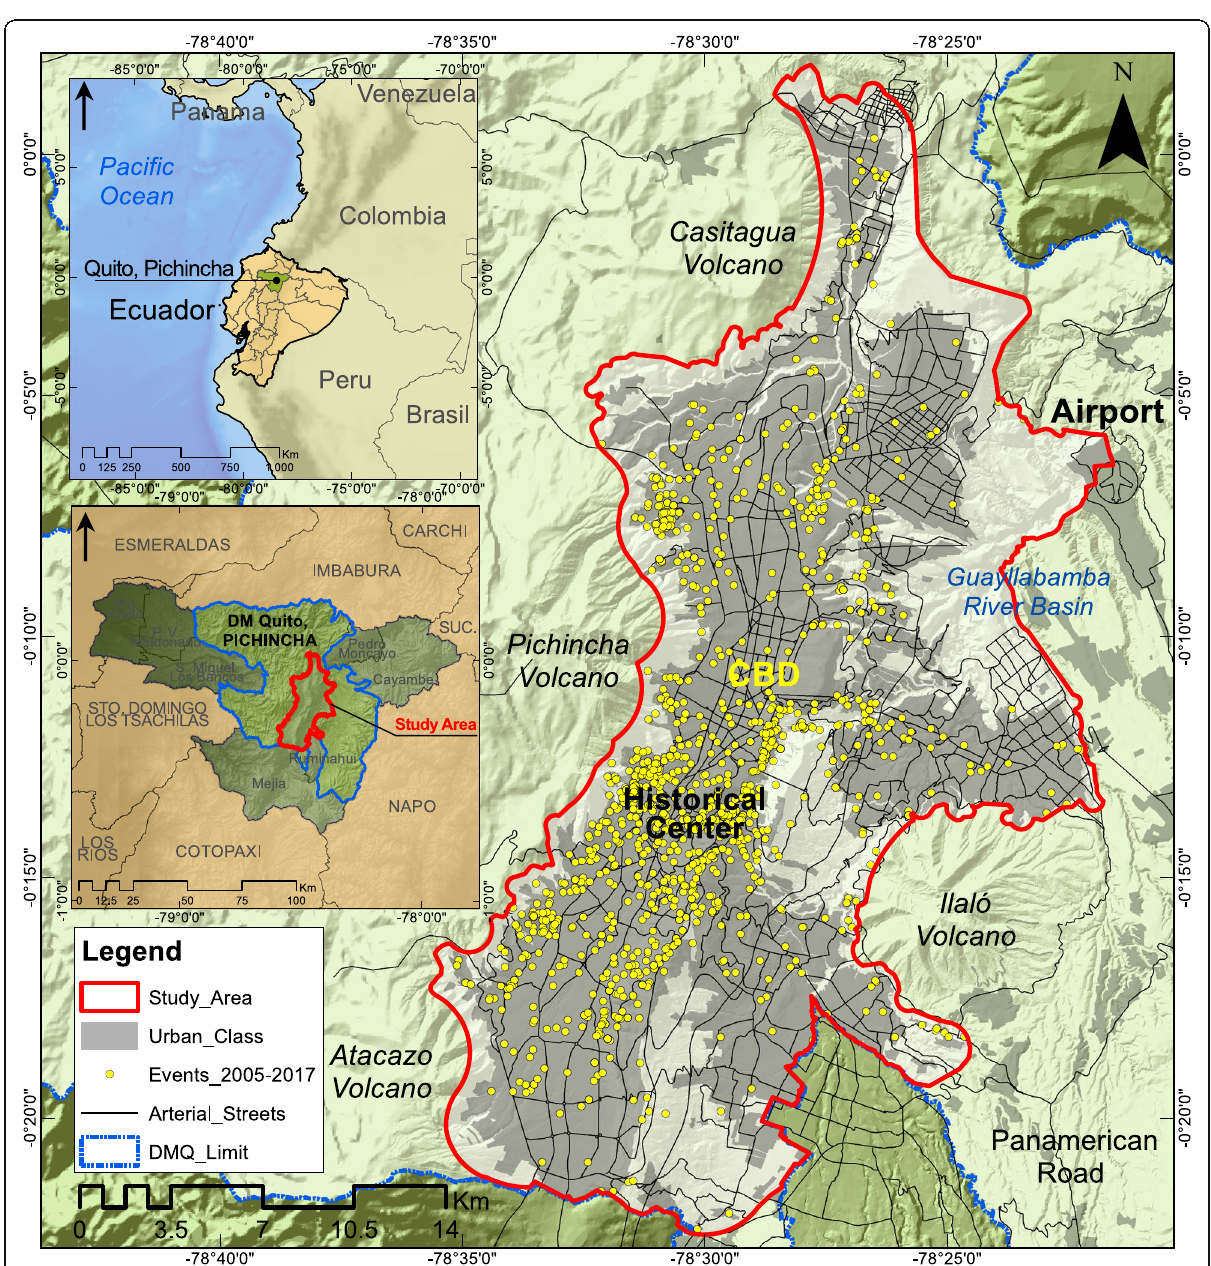
Fig. 1 Study Area in the Metropolitan District of Quito, displaying the 2005 – 2017 period landslide events. Data Source: MDMQ, IGM Ecuador. Legend: Study Area (red line), Urban Class (gray polygon), Landslide Events during the 2005 – 2017 period (yellow dots), Arterial Streets network (black continuous lines) and the Metropolitan District of Quito jurisdictional limit (dashed blue